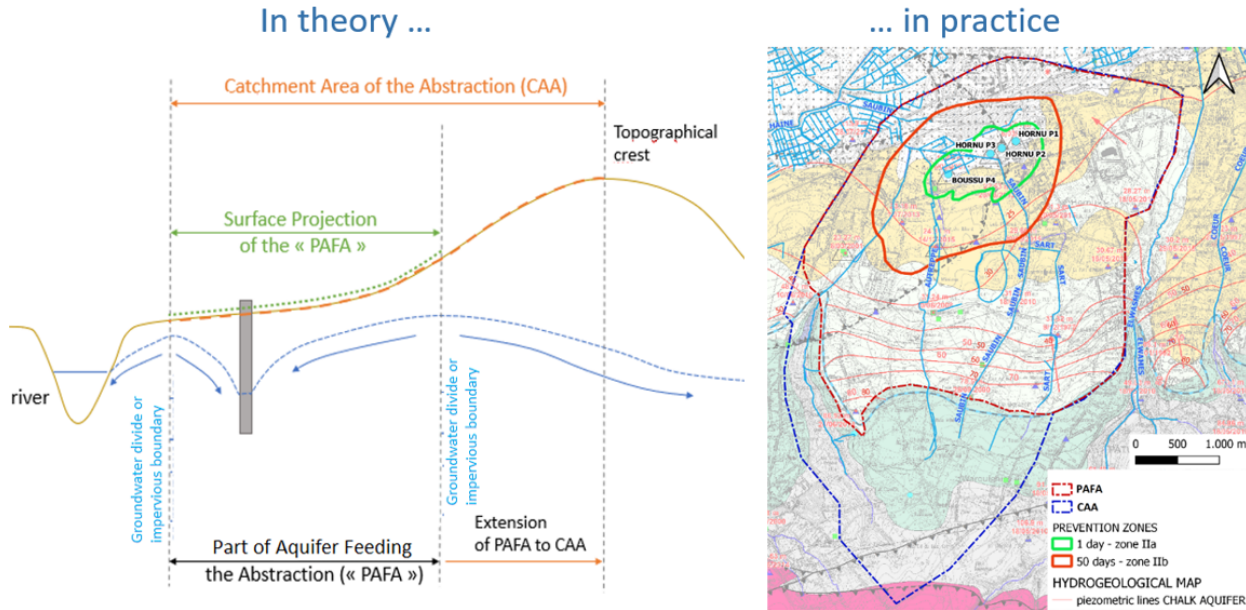
Figure 4. Methodology for the delineation of the catchment area of the abstraction point (a) on the left, in particular of the CAA – catchment area of the abstraction and the PAFA – part of aquifer feeding the abstraction, and its application to the CASPER case study (b) on the right, with map Carte Quiévrain – Saint-Ghislain_4556 as